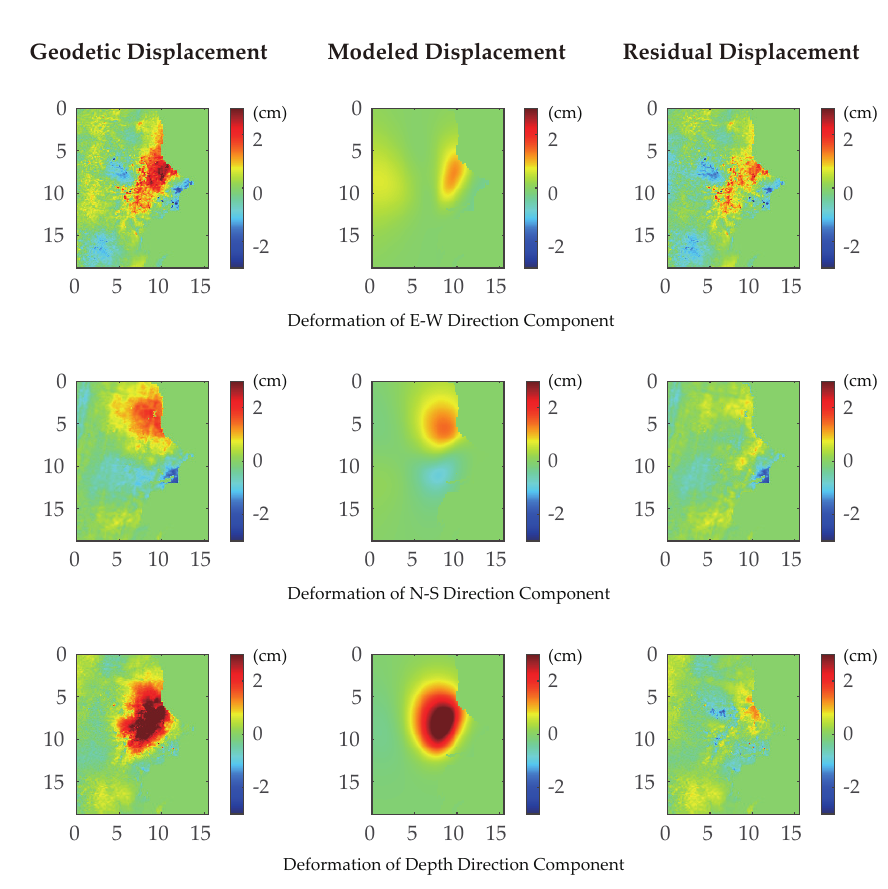
Figure 12. Final results of source